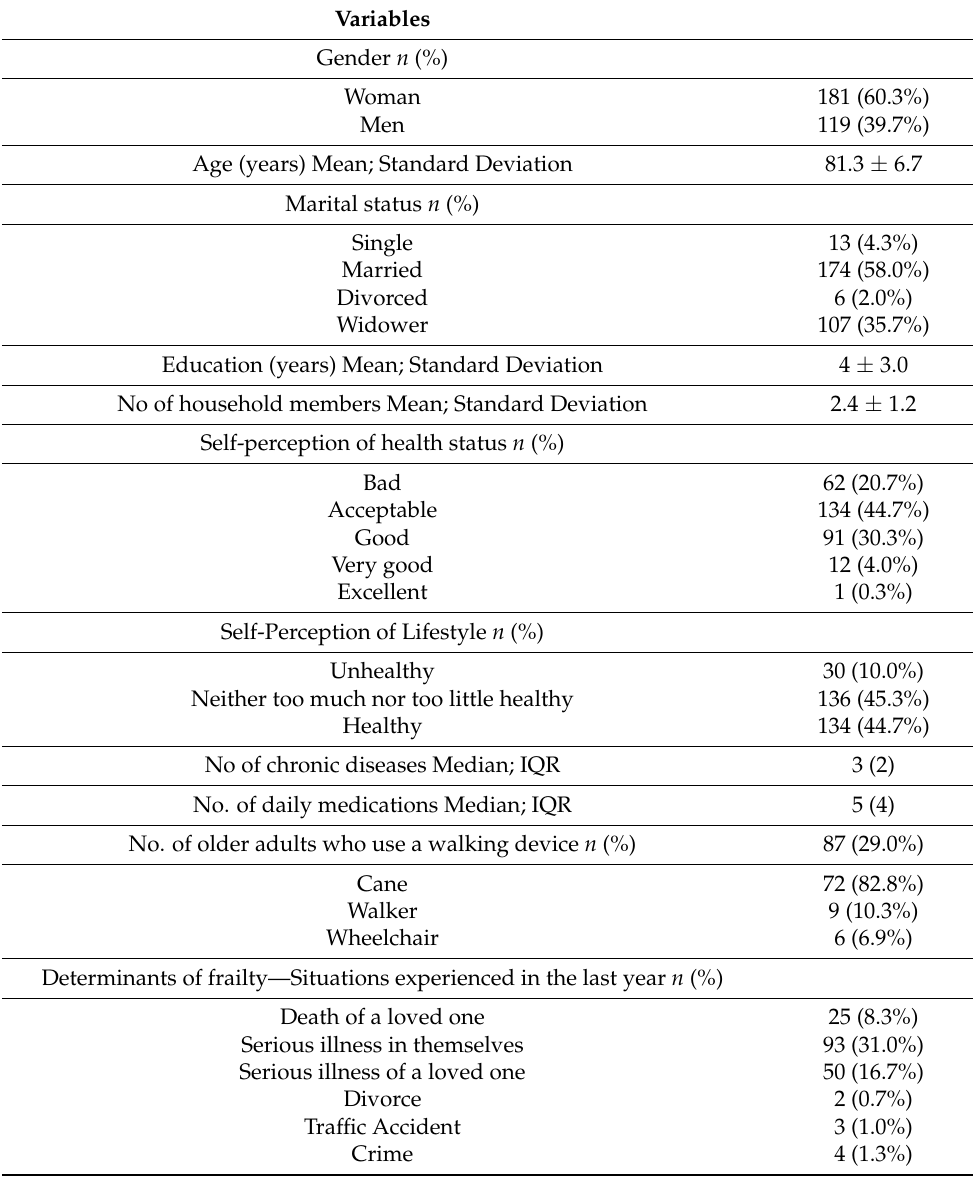
Table 1. Socio-demographic and clinical characterization of the participants (N =